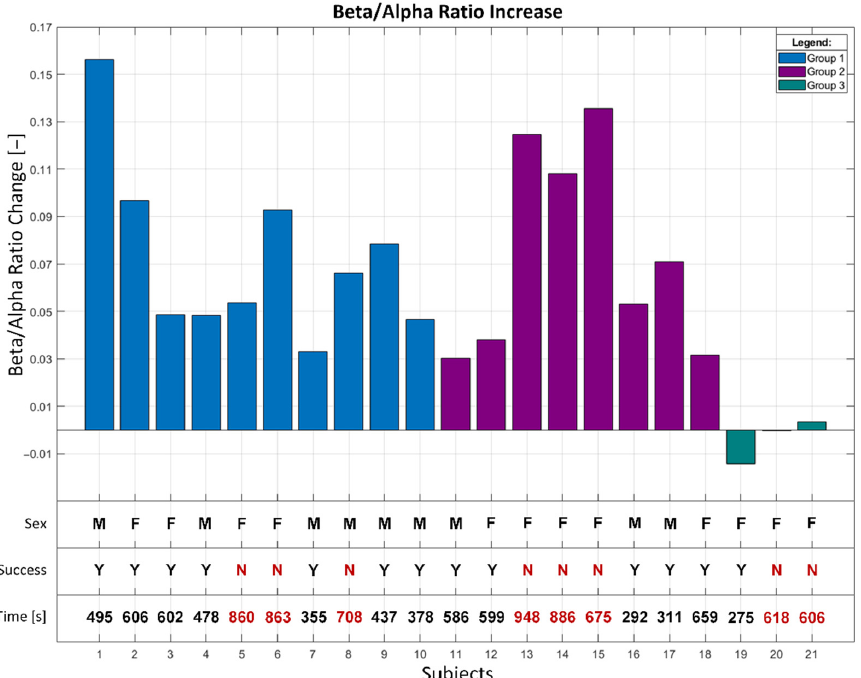
Figure 13. Increase of the brain activity during the gameplay across all respondents.